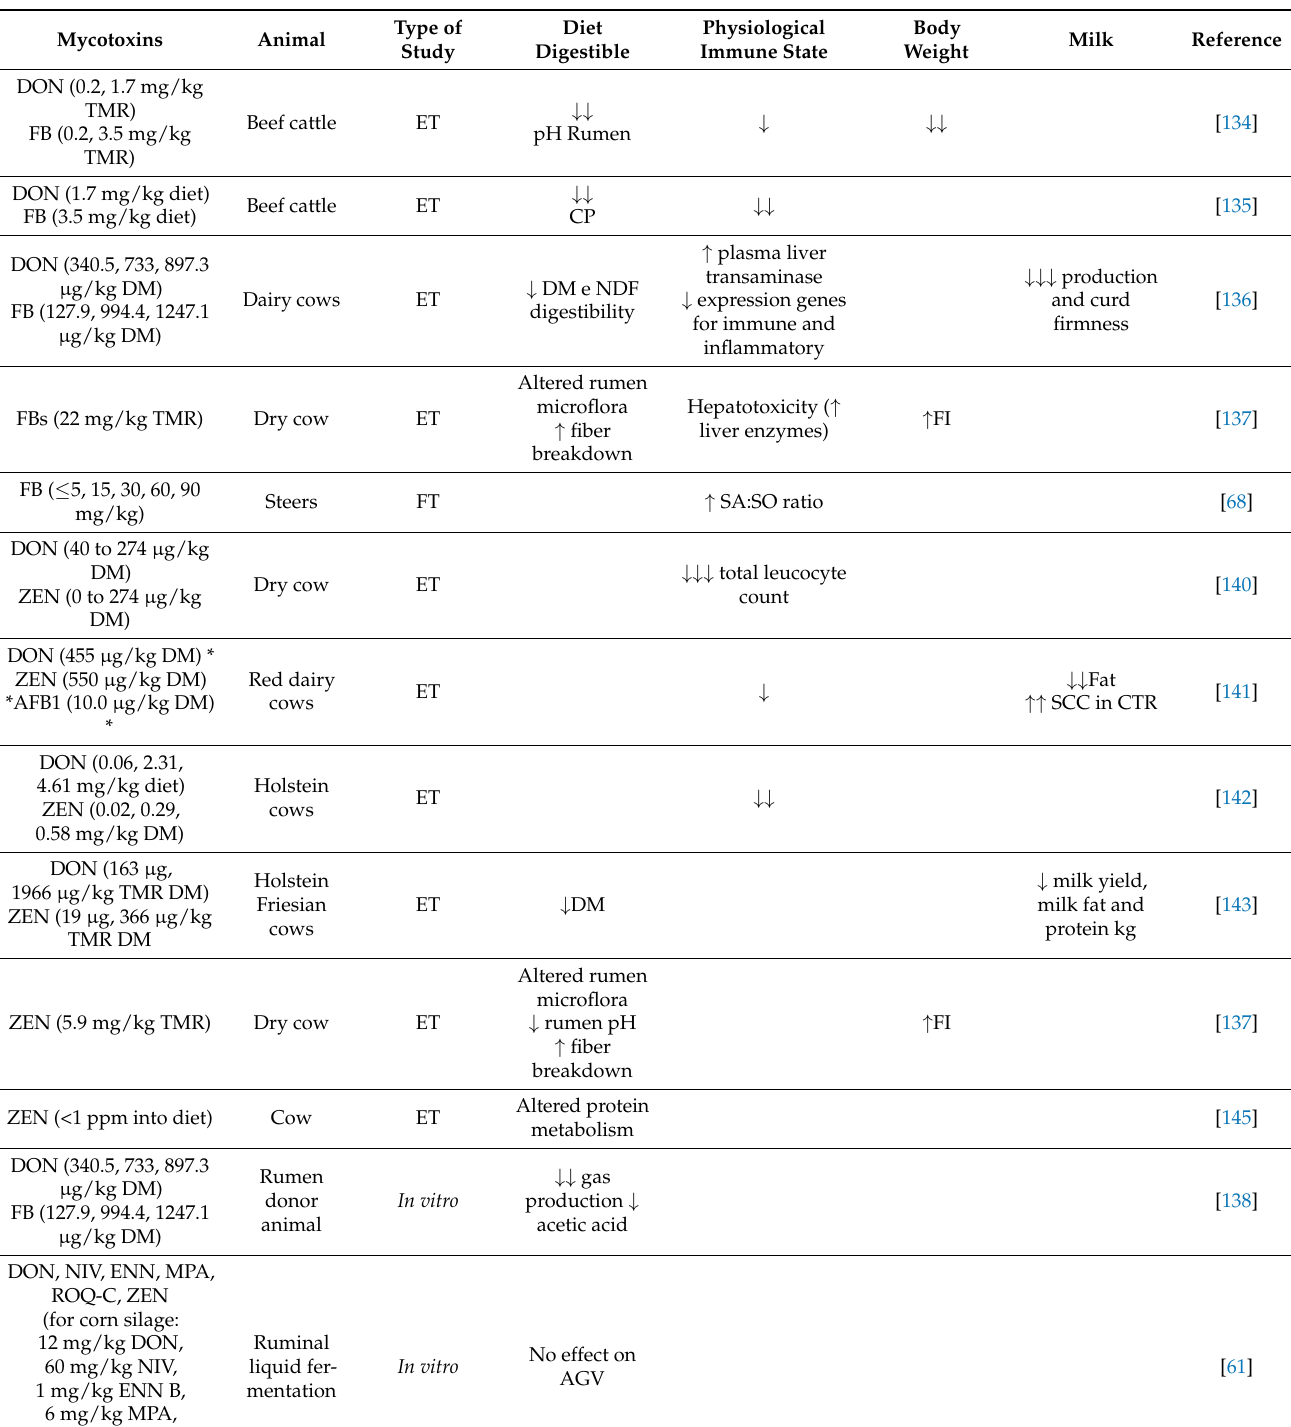
Table 2. Effects of Fusarium toxins on livestock revealed from trials published from 2015 to